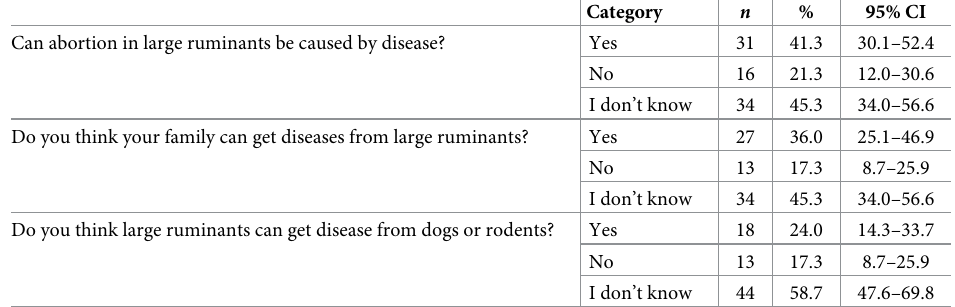
Category n % 95% CI